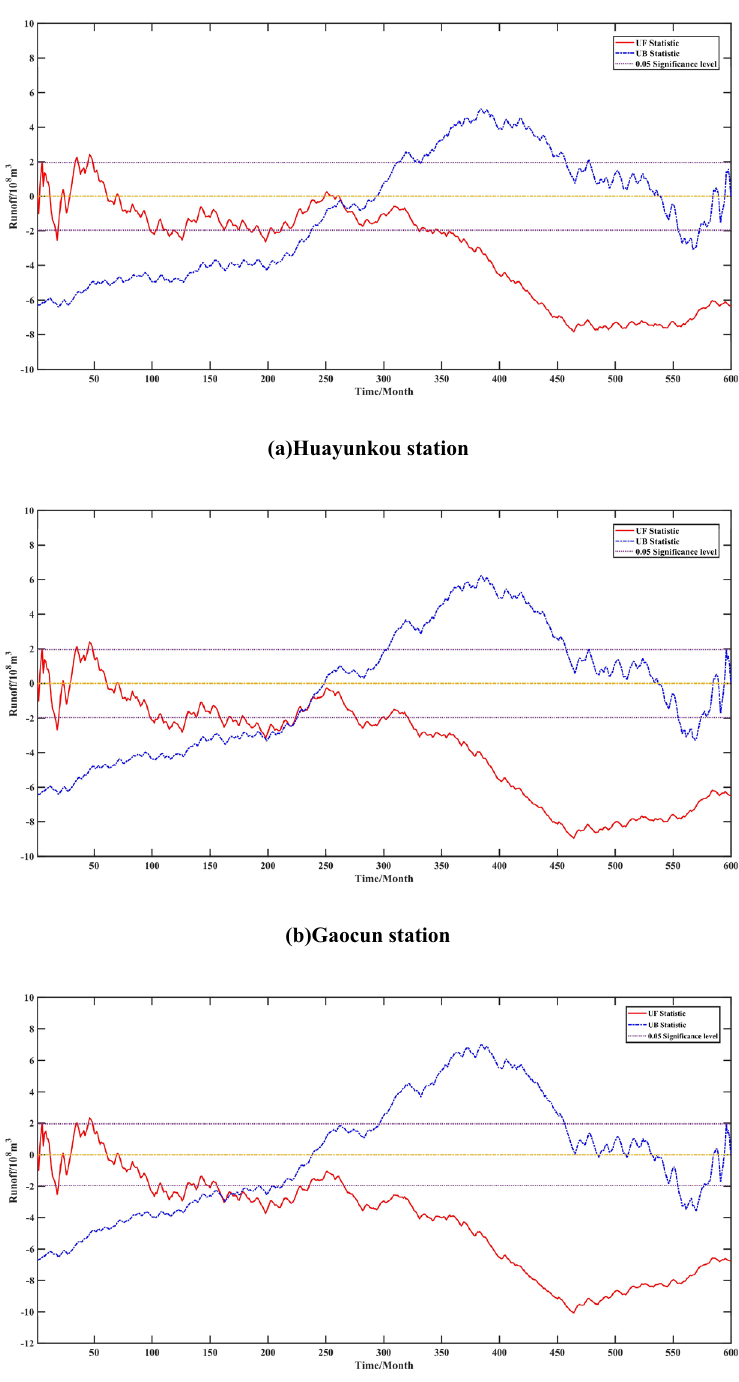
Figure 5. Mann–Kendall test for runoff from January 1965 to December 2014 at each